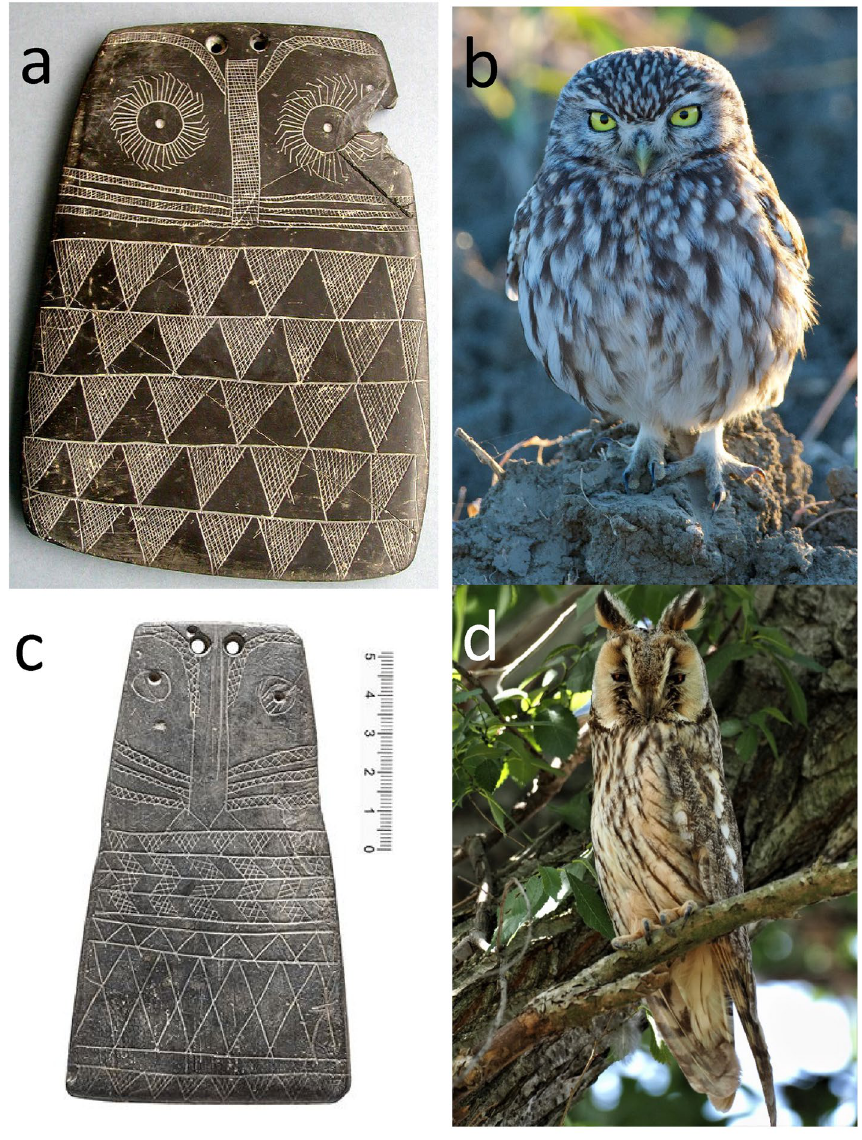
Figure 2. Upper left ( a ), Engraved slate plaque found in Cerro de la Cabeza, Valencina de la Concepción, Sevilla, España (Museo Arqueológico de Sevilla, Spain), representative of the zoomorphic type recognized by Lillios 2 . Upper right ( b ), wild little owl ( Athene noctua ) pictured in an agricultural area in Valencina de la Concepción in 2021. Bottom left ( c ), slate plaque from Mértola, Alentejo, Portugal (MNA, Lisboa, 2006.370.1). The orifices on the upper part may have been used to insert actual feathers. On the right ( d ), long-eared owl ( Asio otus ) with erected ear tufts, pictured in Valencina de la Concepción in 2021. Credits little and long-eared owls: Juan J.